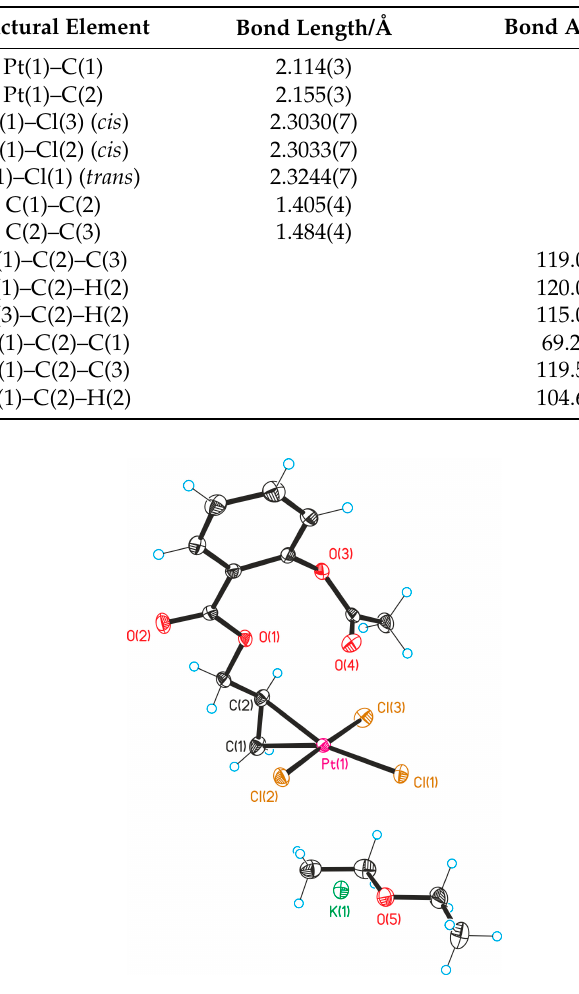
Table 1. Selected bond lengths and bond angles in the crystal of 1a .